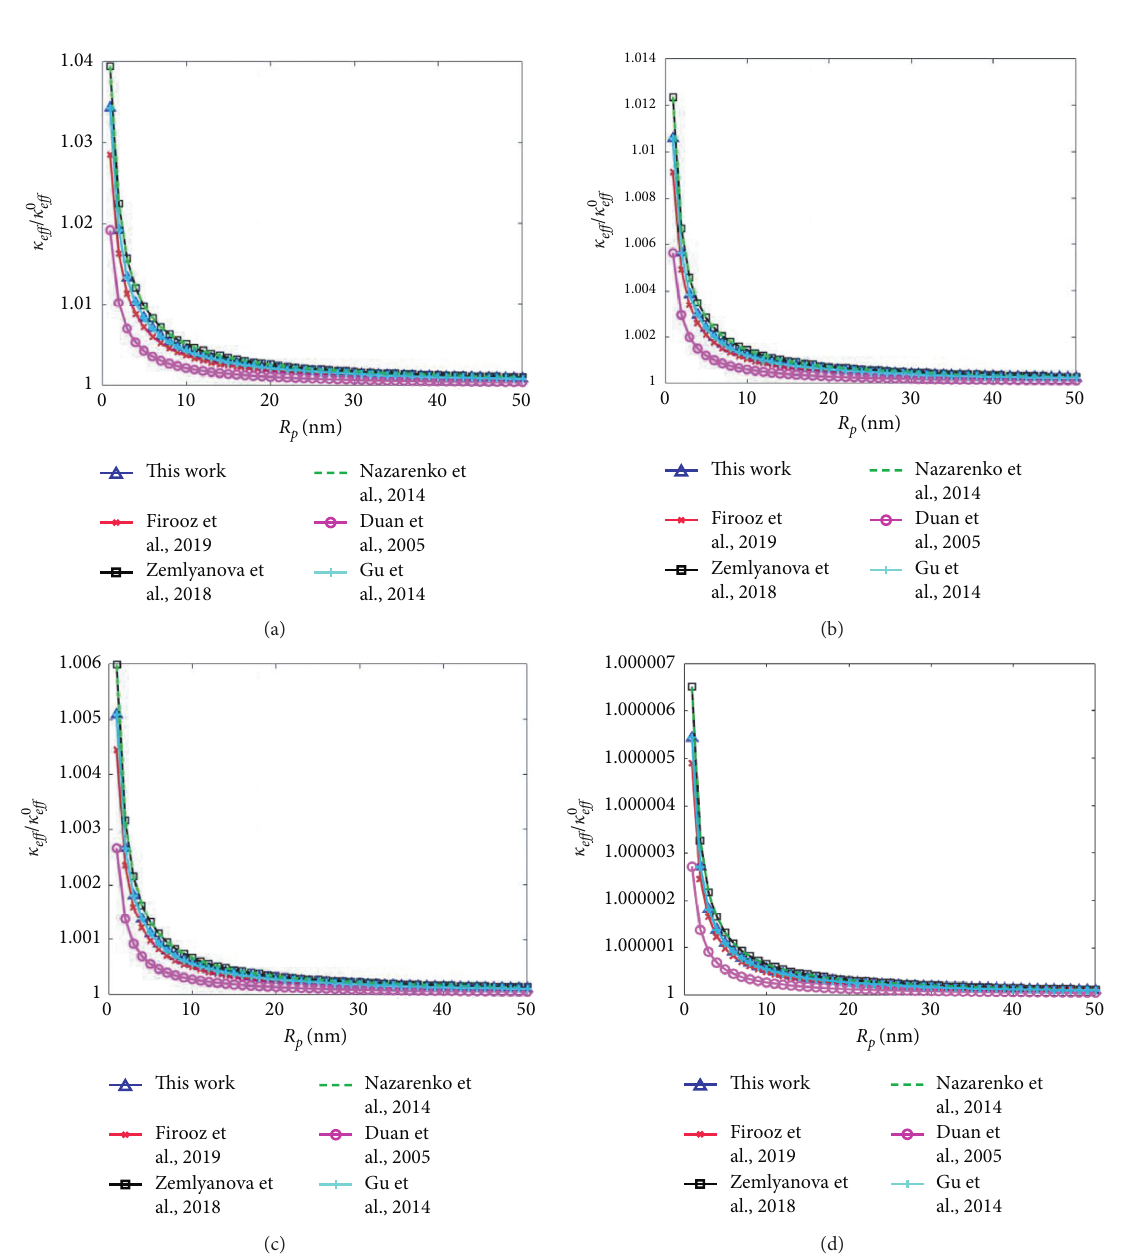
� 0.4 and (a) E v p /